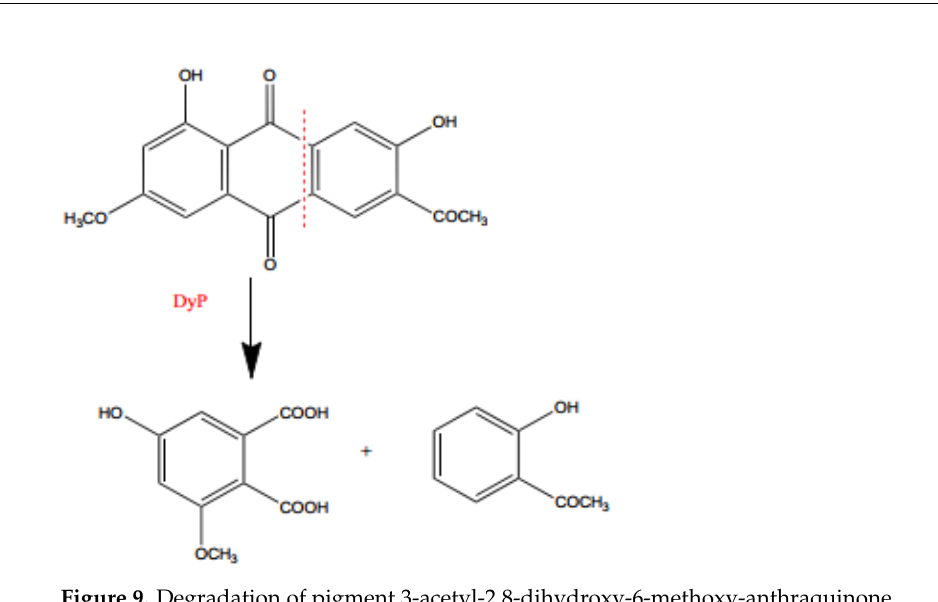
Figure 9. Degradation of pigment 3-acetyl-2,8-dihydroxy-6-methoxy-anthraquinone.